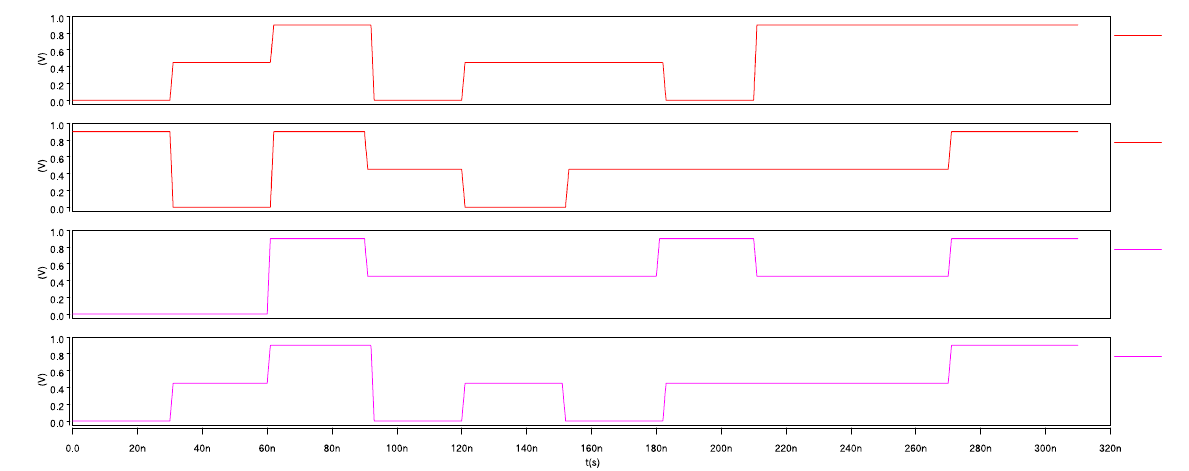
Figure 17. Input waveforms of 2-trit CNTFET-RRAM ternary comparator module.